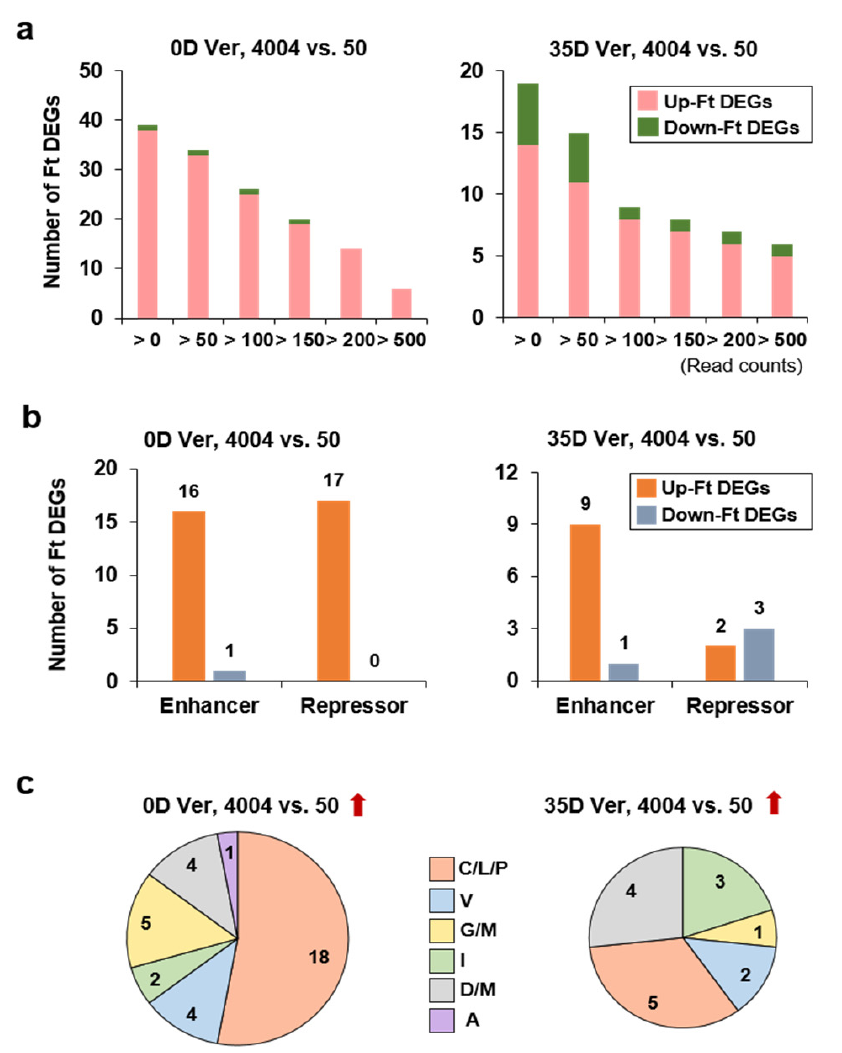
Figure 4. Flowering time-related DEGs based on the comparison between lines “4004” and “50”. ( a ) The expression map of the up-regulated flowering time DEGs according to the expression level comparison of “4004” vs. “50”. The bar graph shows the number of flowering time DEGs based on “4004” vs. “50” plants. ( b ) Classification of flowering time DEGs according to flowering enhancer/repressor criteria. The bar graph shows the number of up-regulated flowering time DEGs based on “4004” vs. “50” plants (read count > 50). ( c ) Circle graph distribution of flowering time DEGs according to flowering pathways. Red arrowheads indicate up-regulated DEGs detected by comparing “4004” vs. “50”. C/L/P, circadian clock, light signaling and photoperiod); V, vernalization; G/M, gibberellin signaling and metabolism; I, integrator; D/M, development and meristem response; A,